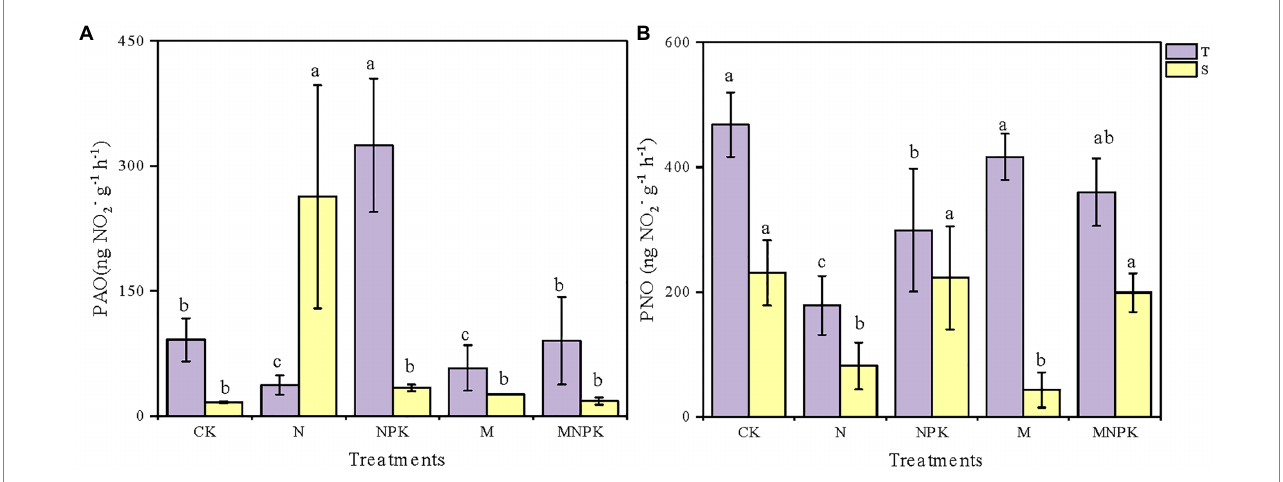
FIGURE 1 Soil potential ammonia oxidation (PAO). (A) Potential nitrite oxidation (PNO). (B) Under different fertilization regimes in the two soil layers. Values are shown as mean ± standard deviations ( n = 3). Different letters above the bars indicate significant difference among fertilization regimes using the Duncan multiple- range test. T, topsoil 0–20 cm; S, subsoil 20–40